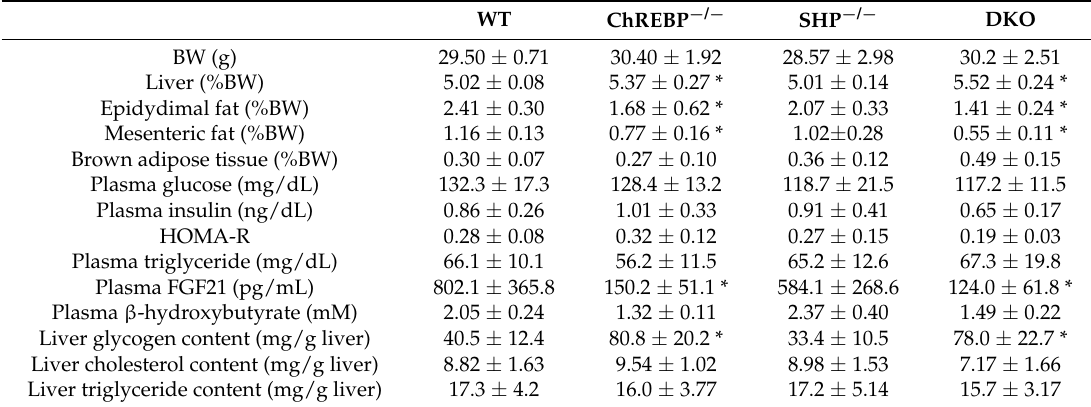
Table 1. Phenotypic comparison between WT, ChREBP − / − , SHP − / − , ChREBP − / − SHP − / − (DKO)